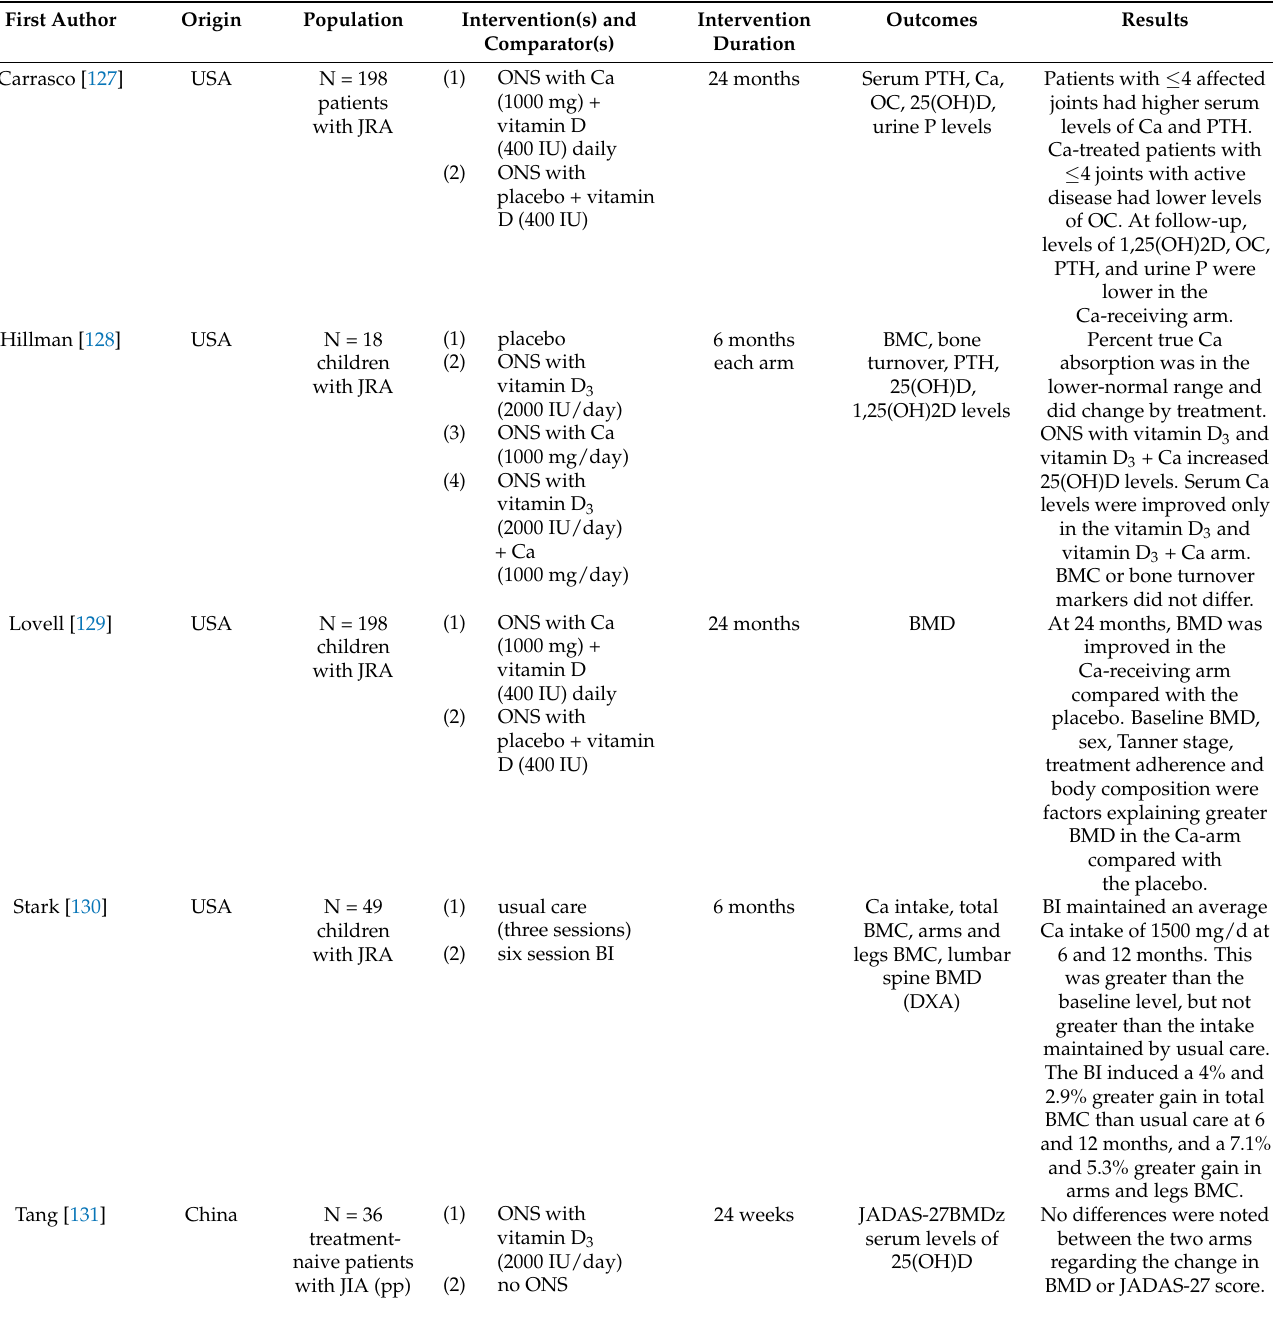
Table 3. RCTs delivering dietary interventions for improving bone health in children with